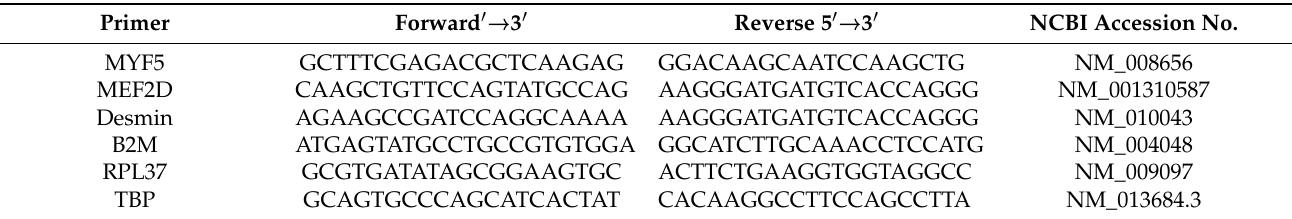
Table 1. Primers used for the analysis of gene